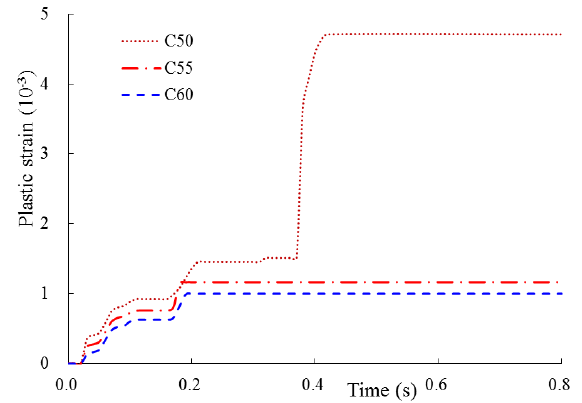
Figure 12. Max plastic strain time-history of concrete.